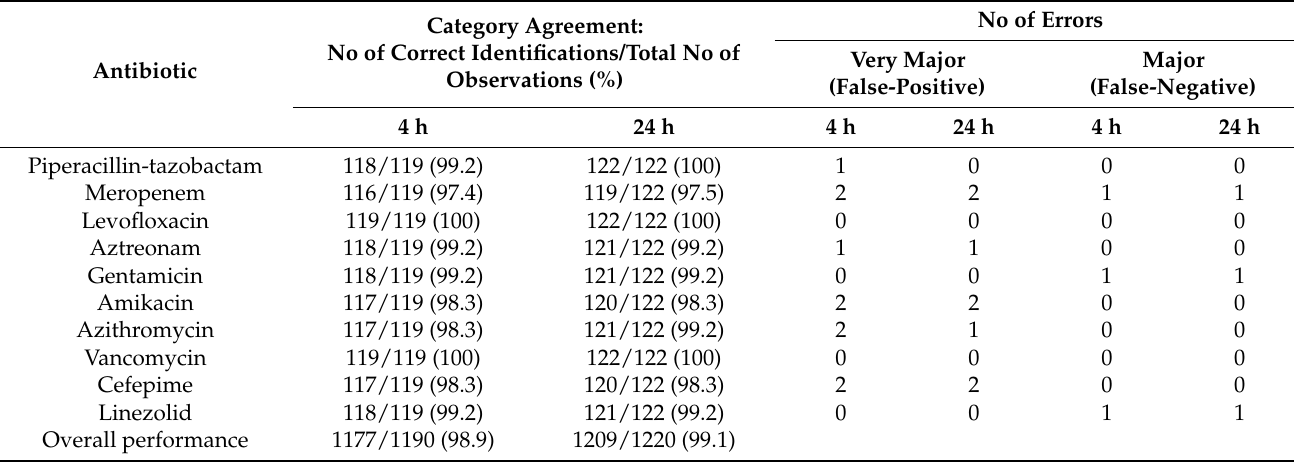
Table 3. Category agreement of antibiotic sensitivity results of the AtbFinder method with those obtained by the standard method after 4 and 24 h of